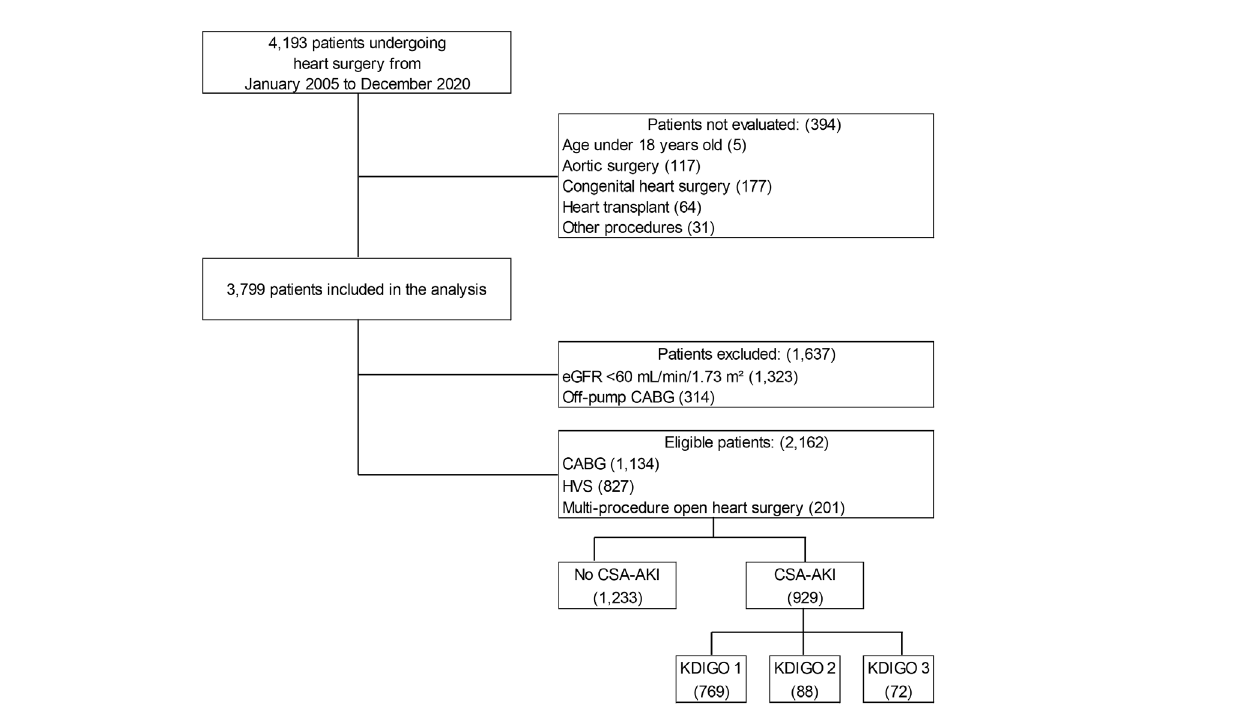
Fig. 1 - Study flow chart showing patients who underwent cardiac surgical procedures and who were divided into two groups according to the development of cardiac surgery-associated acute kidney injury (CSA-AKI) based on the Kidney Disease Improving Global Outcomes (KDIGO) classification. CABG=coronary artery bypass grafting; eGFR=estimated glomerular filtration rate; HVS=heart valve